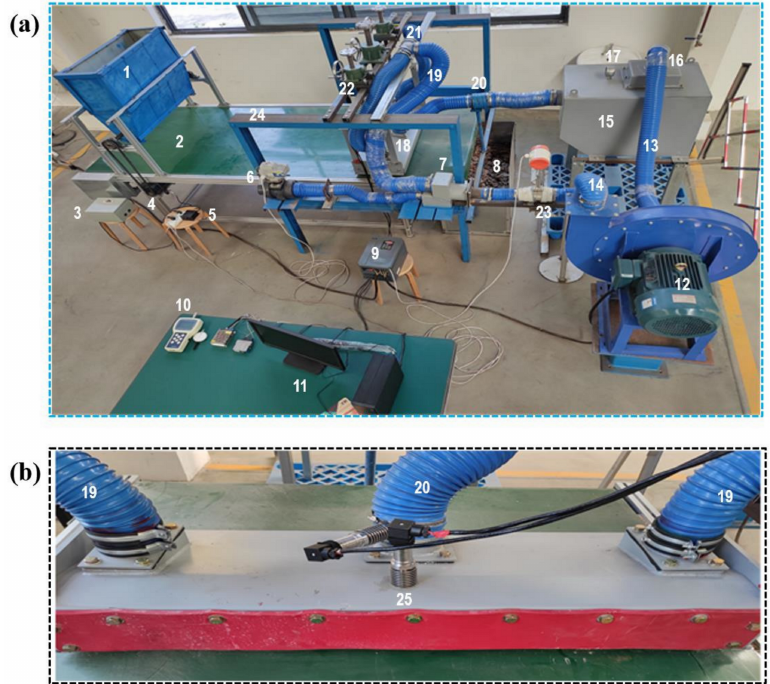
Figure 5. ( a ) Experimental setup of a regenerative air vacuum sweeper. ( b ) Close-up of the